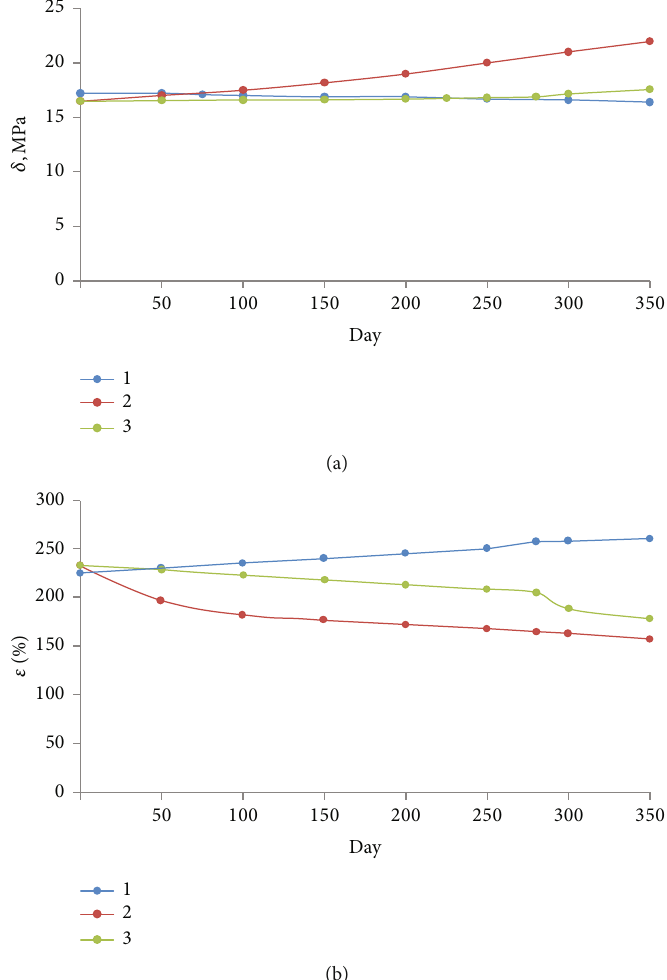
Figure 5: The change of physical and mechanical properties of plasticized PVC fi lms during full-scale test: (a) Tensile breaking stress. (b) Elongation at